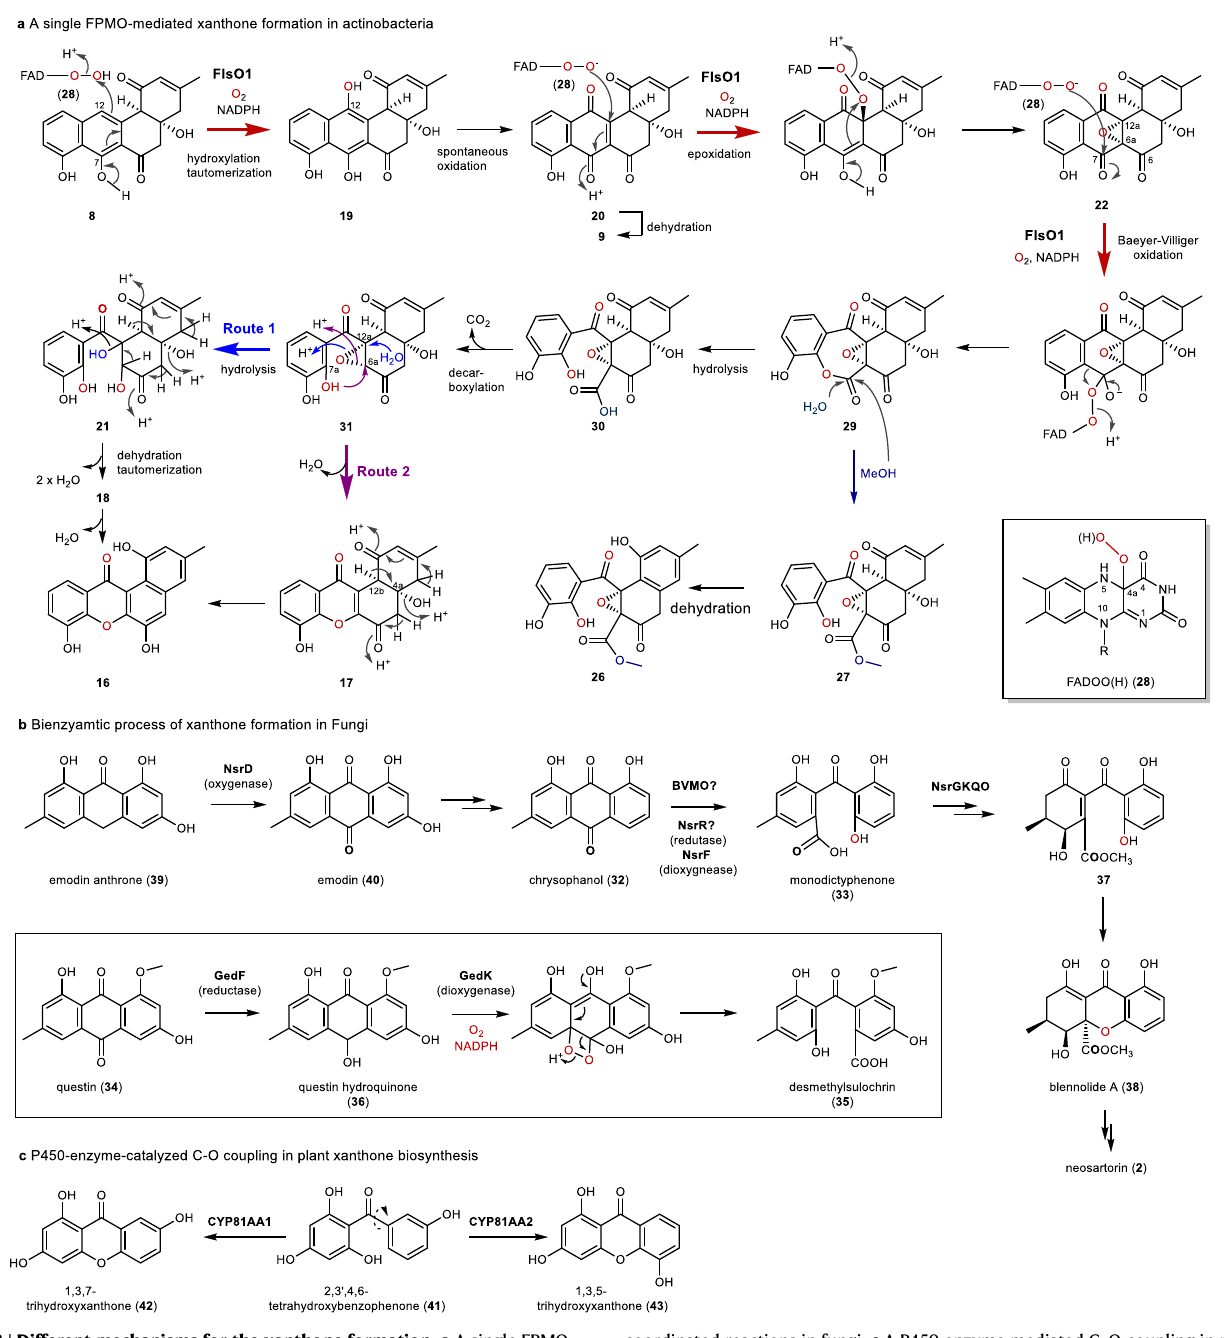
coordinated reactions in fungi. c A P450 enzyme-mediated C ‒ O coupling in plant biosynthesis of